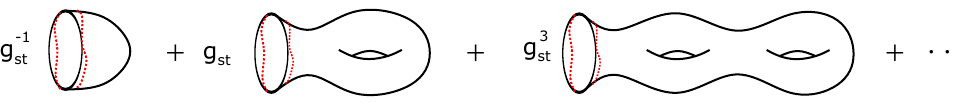
Figure 1 . The perturbative expansion of the WdW wavefunction in powers of g st (cid:24) 1 =(cid:22) . The dashed lines indicate that we keep (cid:12)xed only the overall size of the loop ‘